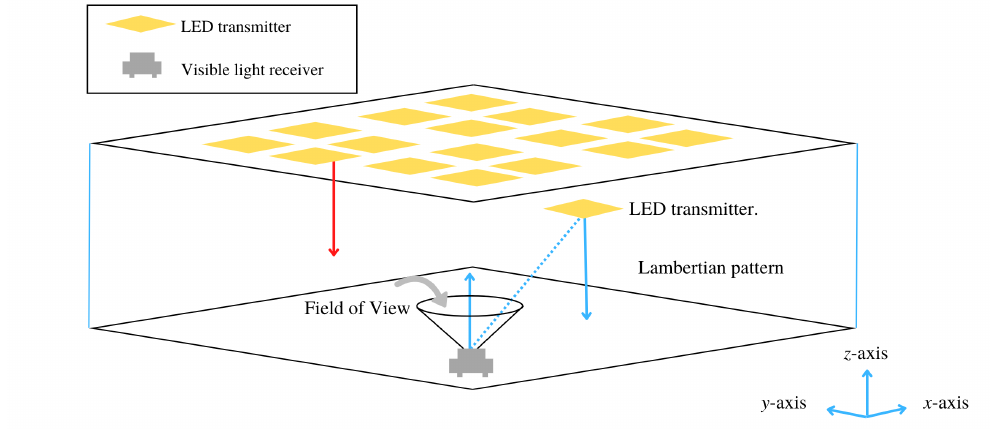
Figure 4. Illustration of the VLC-based positioning system.